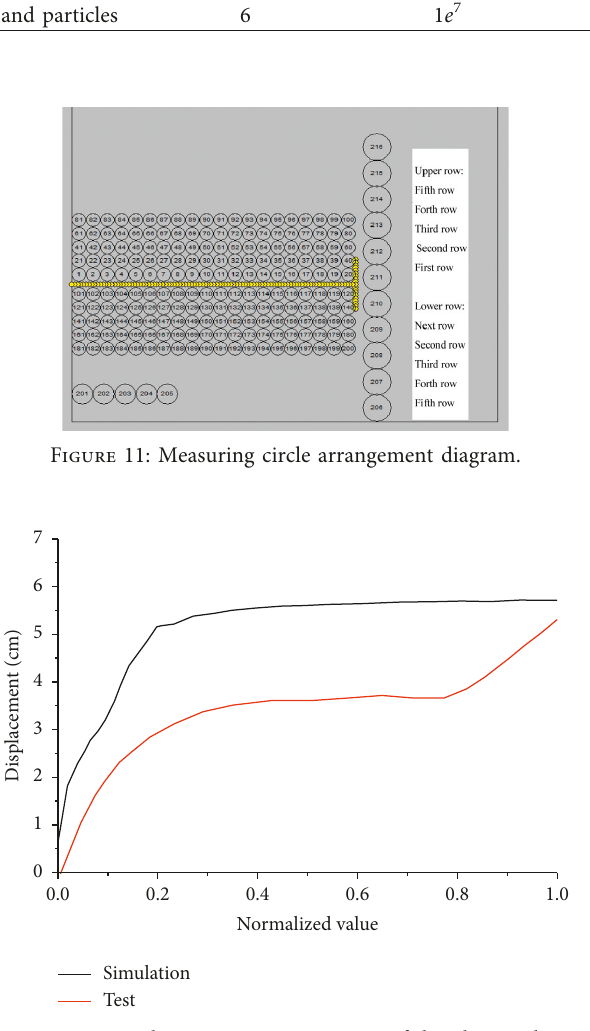
Figure 12: Displacement-time step curve of the plate anchor.